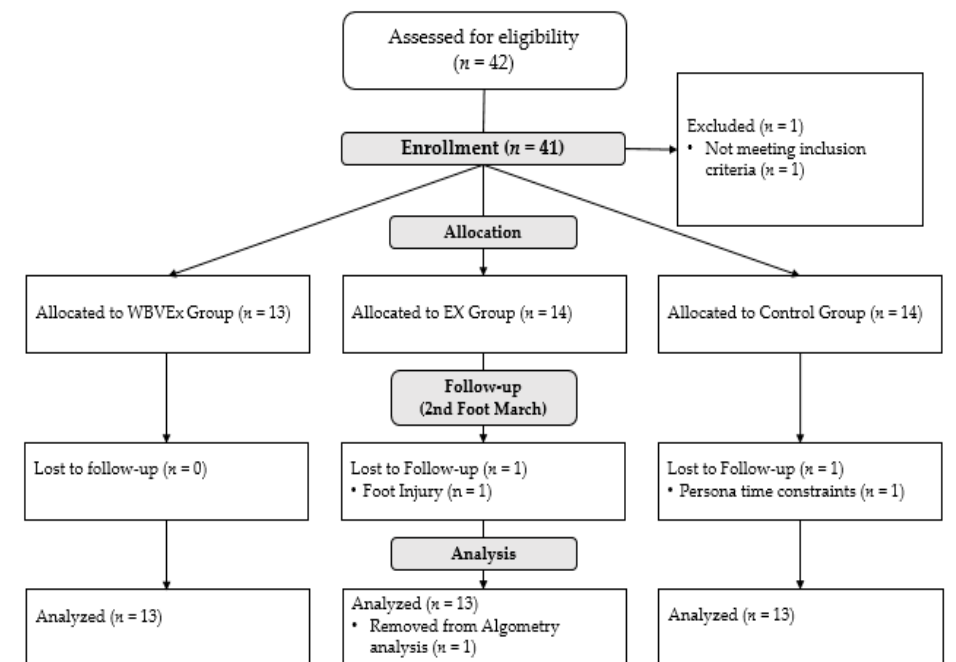
Figure 2. Flow diagram of study recruitment. Table 1. Summary of descriptive statistics.